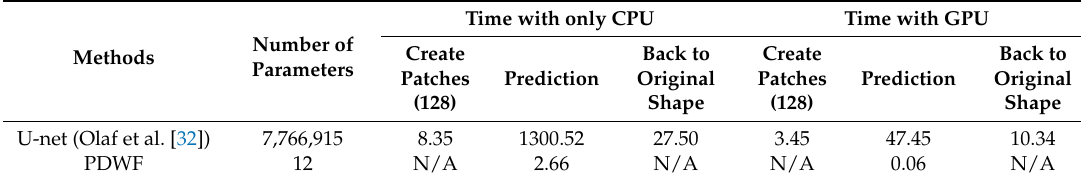
Table 5. Comparison in terms of processing time for